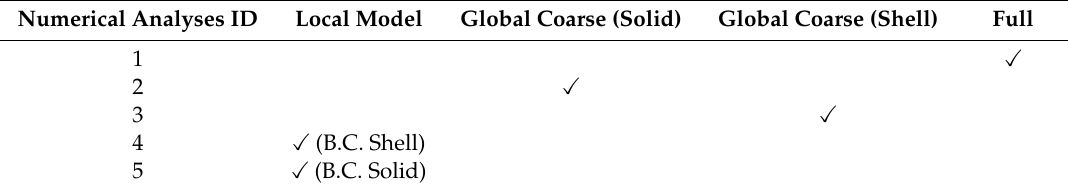
Table 1. Overview the finite element analyses